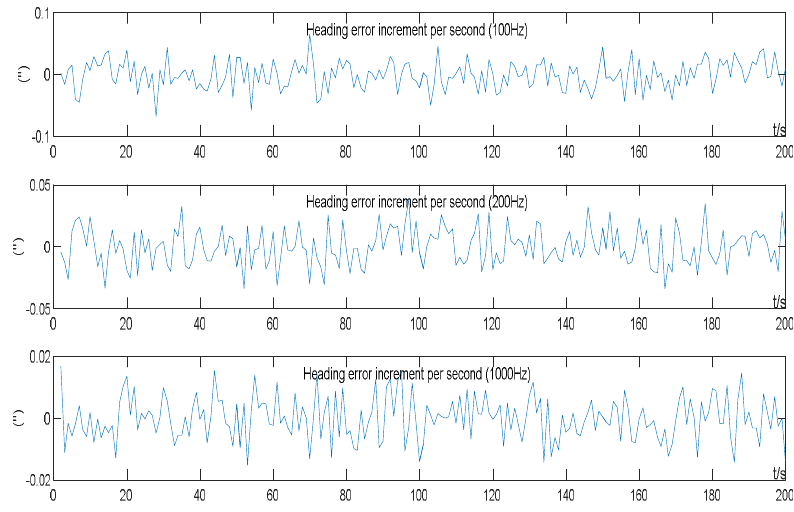
Figure 4. Heading error of the simulation test with different sampling frequencies.